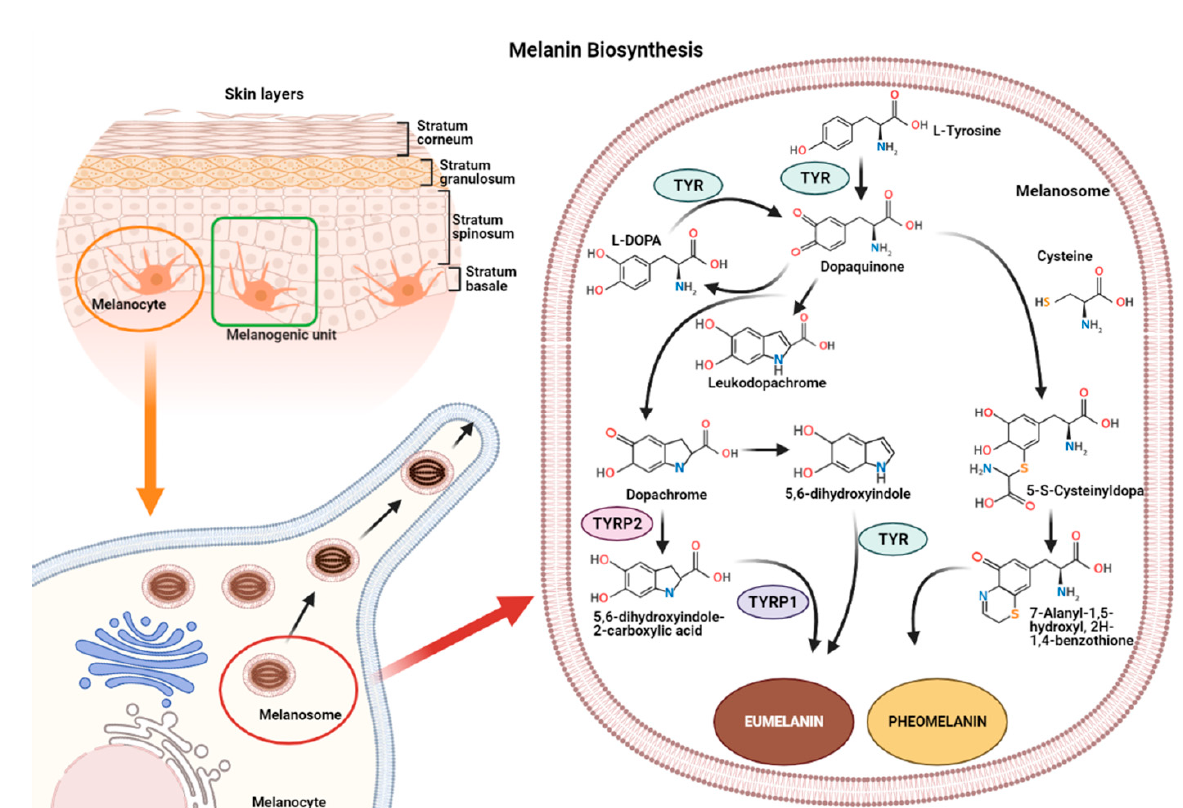
Figure 1. Representation of the melanogenic unit and melanin synthesis in melanosomes ( left ). Schematic representation of eumelanin and pheomelanin biosynthetic pathways ( right ).